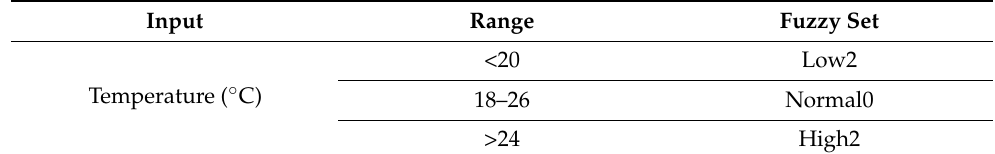
Table 5. Ranges of temperature and their respective fuzzy sets.